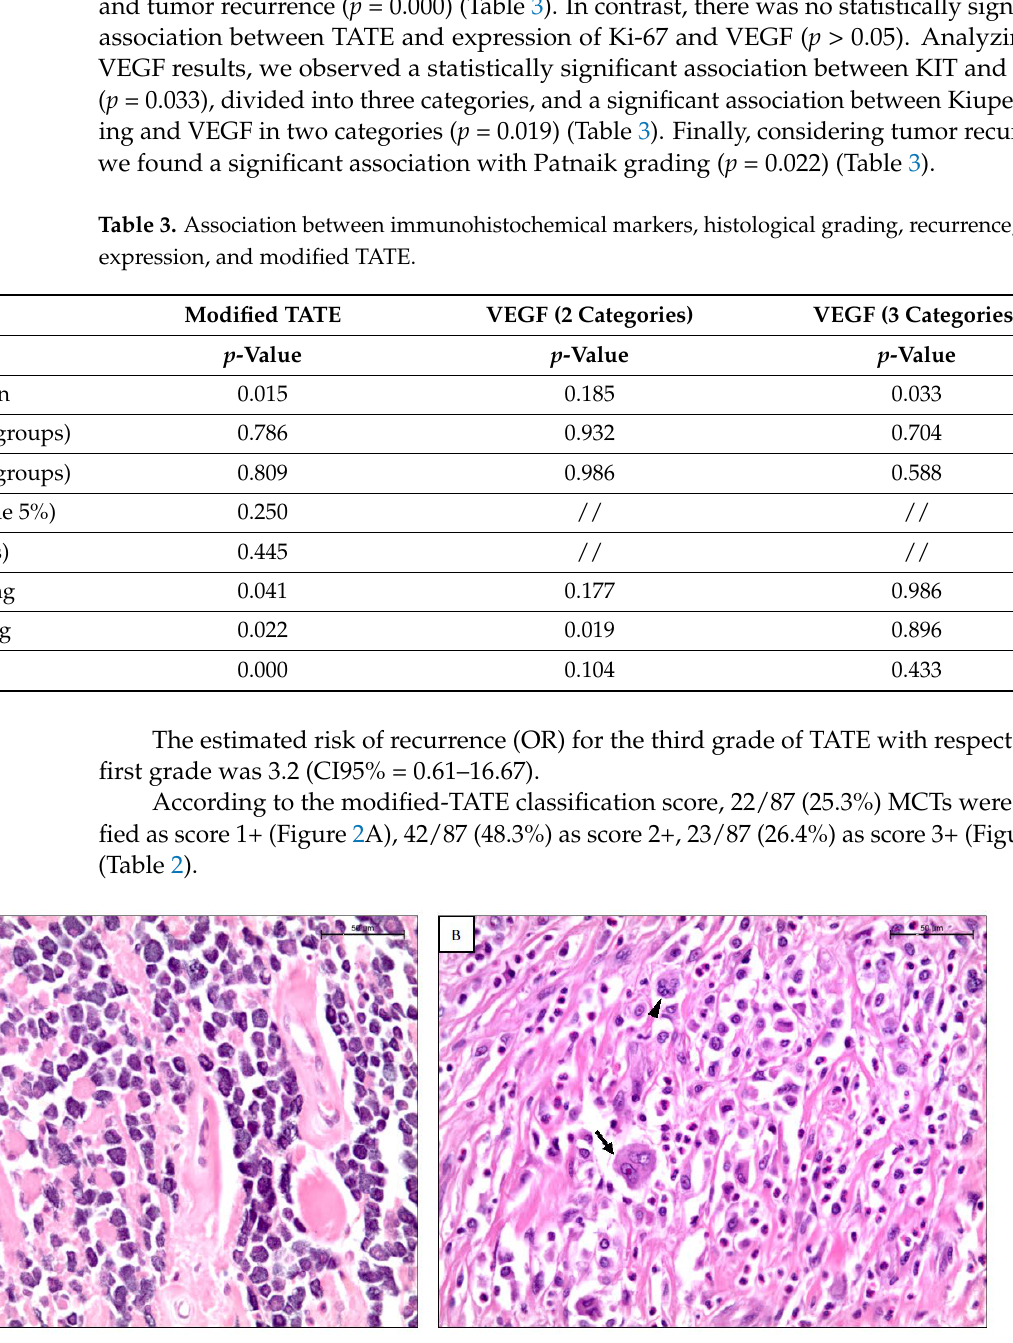
Figure 2. ( A ) Canine cutaneous mast cell tumor with a TATE score of 1+. H-E, scale bar 50 μm. ( B ) Canine cutaneous mast cell tumor with a TATE score of 3+. Arrow: binucleation; arrowhead: multinucleation. H-E, scale bar 50 μm.